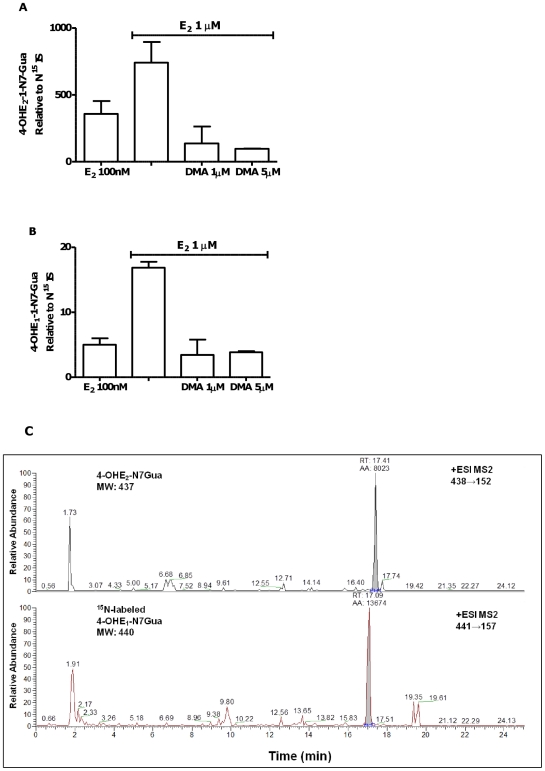
Formation of guanine NCE adducts from MCF-10A cells treated with E2 (0.1 or 1 µM) is inhibited by co-treatment with DMA.Cell culture supernatant was analyzed after 4 days of treatment and 1 week post cell-plating. LC-MS/MS peak area for A. 4-OHE2-1-N7Gua and B. 4-OHE1-1-N7Gua was normalized to equal amounts of internal standard 15N-labeled Gua adduct. C. Representative chromatograms of guanine NCE adducts obtained with the TSQ MS instrument. Guanine adduct 4-OHE2-1-N7Gua from MCF-10A cell media treated with 1 µM E2 after 3 days. 15N-labeled guanine adduct shown in red is the internal standard.